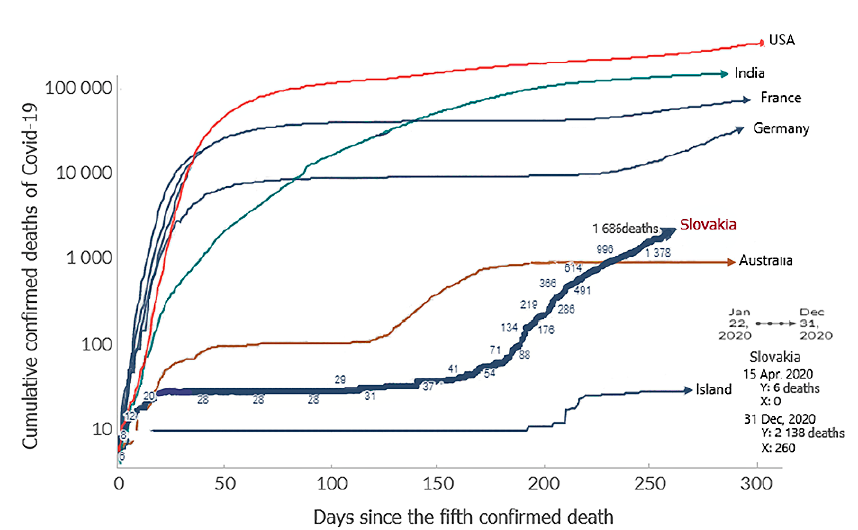
Figure 6. Cumulative confirmed deaths related to Covid-19 in selected countries